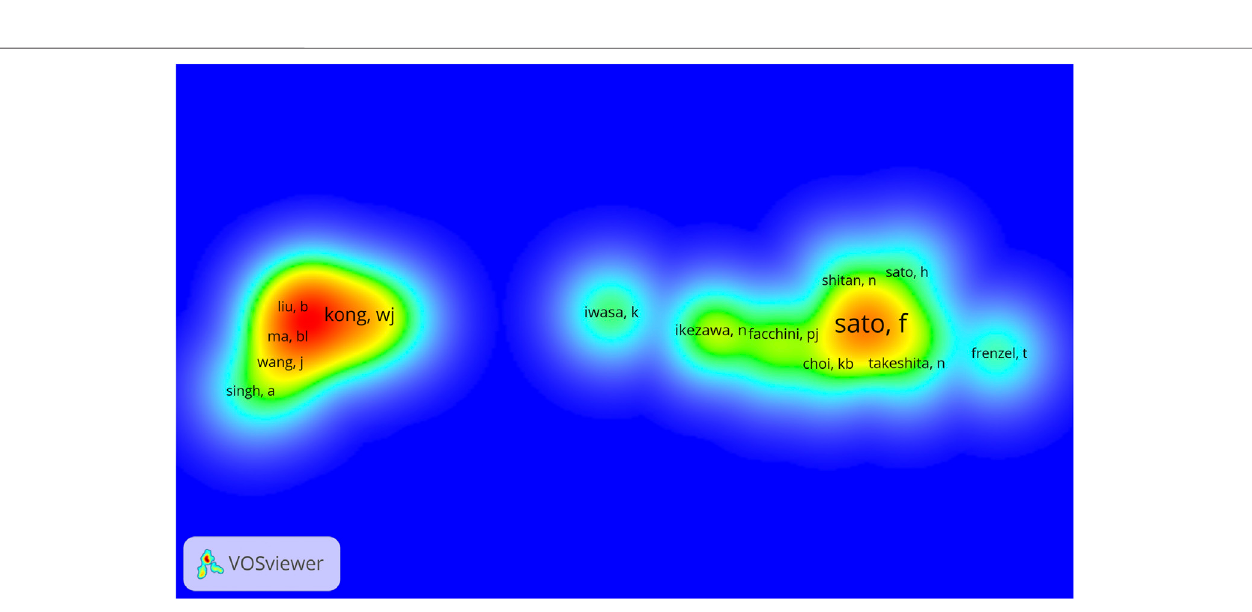
Frontiers in Pharmacology |